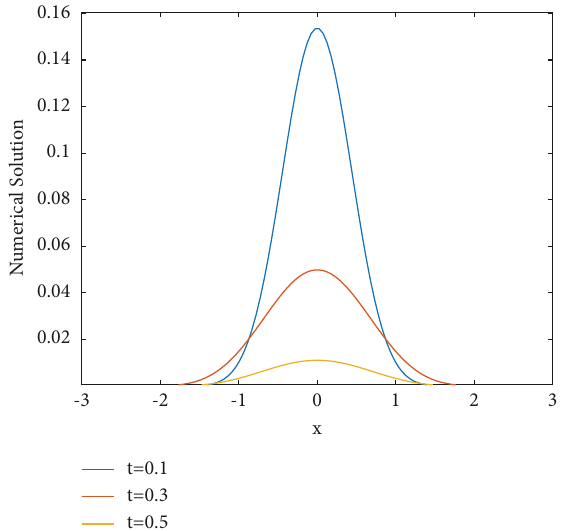
Figure 5: Wave profile of problem 1 at different